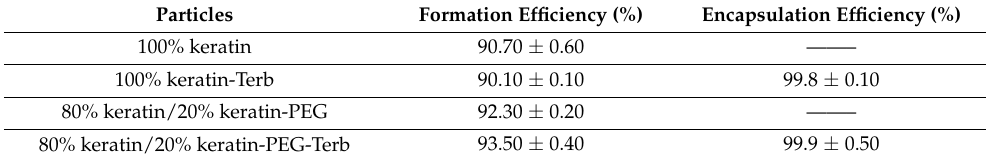
Table 1. Formation and encapsulation efficiency (%) of keratin-based particles with and without terbinafine.